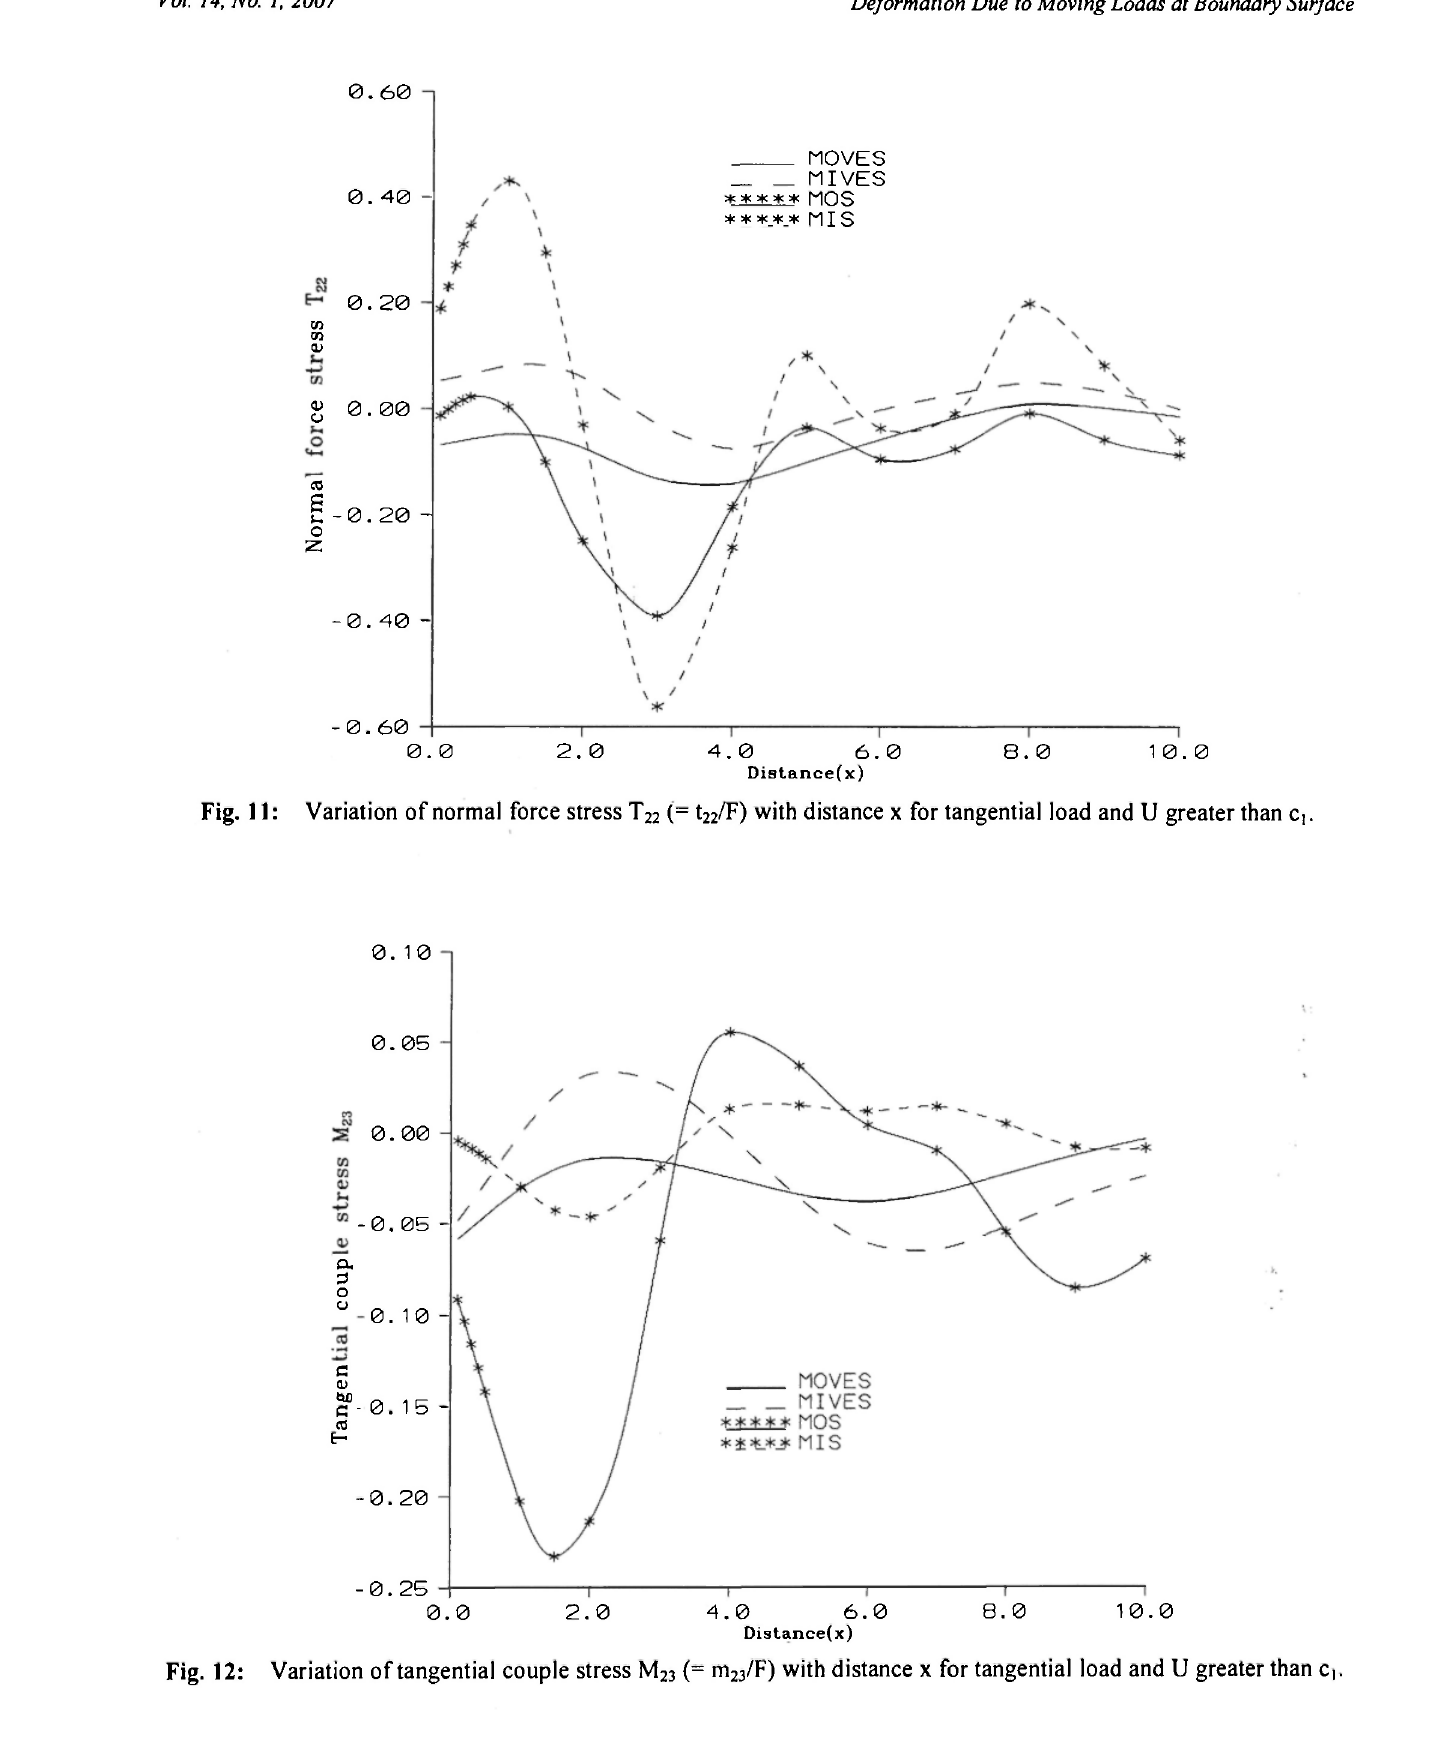
Fig. 11: Variation of normal force stress T 22 t 22 /F) with distance χ for tangential load and U greater than c,.